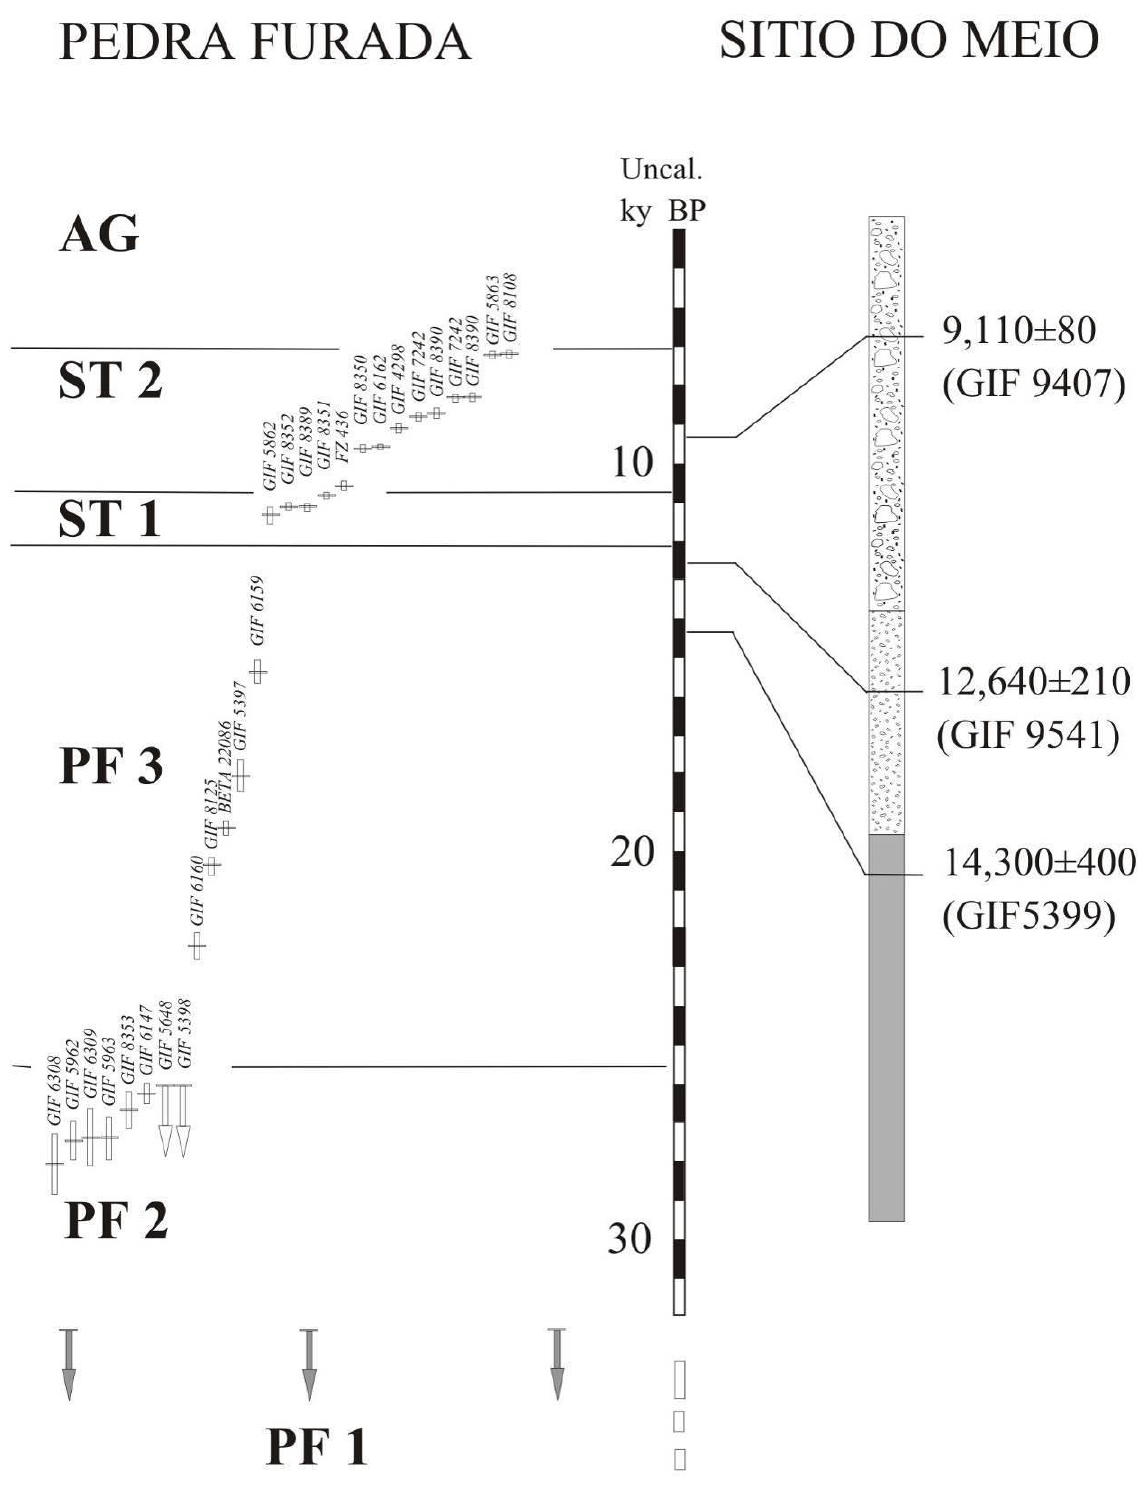
Figure 5. Stratigraphy and chronology of SDM, compared with